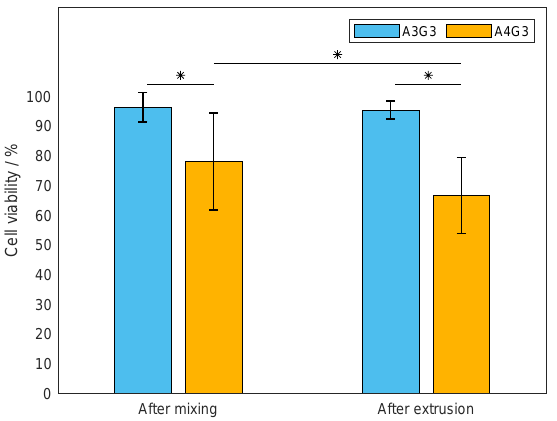
Figure 8. Characterization of the effect of processing on cells. The viability was determined after the mixing step and after the extrusion process. For both bioinks, the mean viability is shown as a bar with the associated standard deviation. The experiments were performed as biological triplicates ( n = 3). For both bioinks, each biological replicate was divided into three fractions, diluted separately ( n = 3), and analyzed as technical triplicates ( n = 3), resulting in data sets consisting of 27 values. Significant differences are denoted with an asterisk ( p <